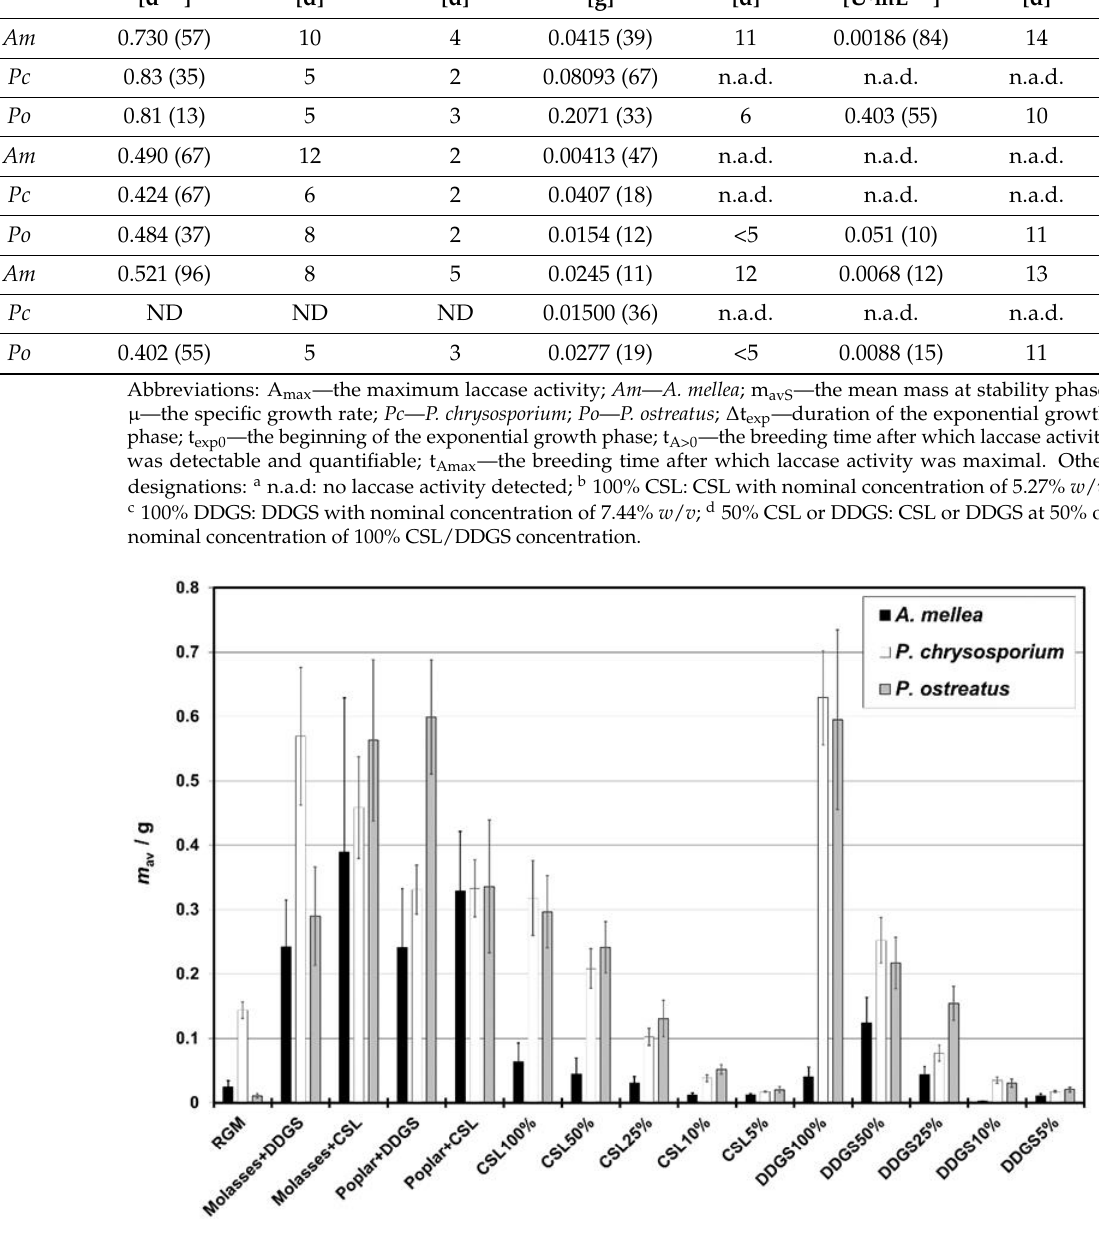
Figure 2. The averaged mass of dried mycelium in the cultures. Abbreviations: CSL—corn steep liquor; DDGS—dried distillers grains with solubles; RGM—reference growing medium; 100% CSL: CSL with nominal concentration of 5.27% w / v ; 100% DDGS: DDGS with nominal concentration of 7.44% w / v ; 50% CSL or DDGS: CSL or DDGS at 50% of nominal concentration of 100% CSL/DDGS concentration.